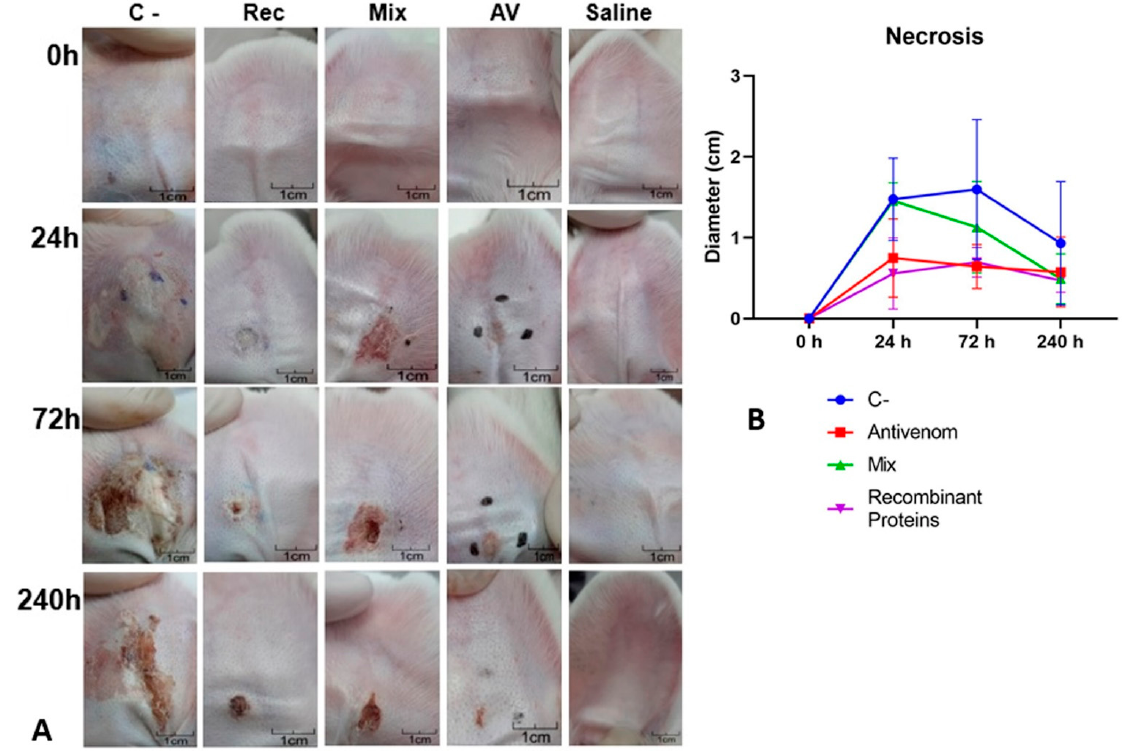
Figure 7. Neutralization of cutaneous loxoscelism in the ear pinna of rabbits. One MND (3.05 µg) of L. intermedia venom was injected (I.D.) in one ear of rabbits (groups of five animals). Immediately after venom injection, 1 mL of the tested serum was administered via the marginal ear vein of the opposite ear. ( A ) Macroscopic aspect of the area injected with venom after the indicated time courses. C-: C serum. Rec: REC serum. Mix: MIX serum. Av: AV serum. Saline: Inoculation of saline instead of venom. Photographs show a representative response to the animals. Black dots marked on the skin surround the local injection. ( B ) Skin necrosis was checked after various time courses (X axis) after injections of 1 MND, followed by inoculation of the tested sera. The intensity of necrosis (Y axis) was classified from 1 to 4 according to the intensity, in which “1” represents a less intense reaction and “4” indicates a more intense sign (adapted from [35]). Each point repre- sents the average intensities of each group measured at the indicated times. Antivenom: AV se- rum. Recombinant proteins: REC serum; Mix: MIX serum. C-: C serum. Results of the groups AV (ANOVA, p = 0.0005) and REC (ANOVA, p = 0.0017) were statistically different from C at 72 h. No significant differences were found when MIX group was compared to C and neither among AV, REC, and MIX at 72 h.